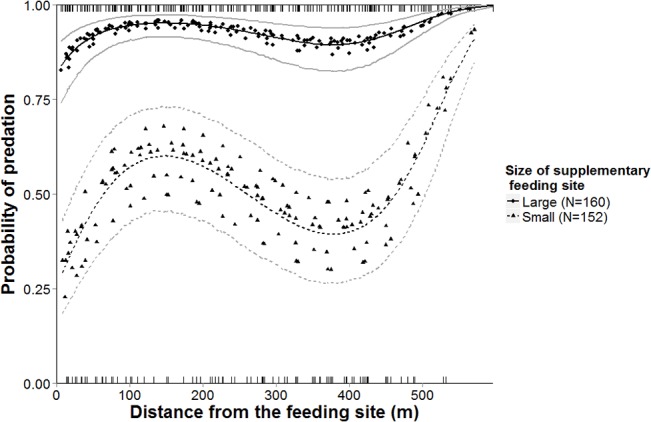
Predicted probability of nest depredation in relation to the amount of food and distance from the feeding sites.Predictions (EBLUPs, denoted as dots or triangles) and estimation (denoted as lines) of predation risk for artificial ground nests, according to the best GLMM in the first experiment. Nest fate is measured on a binomial scale (0 – nest survived, 1 – nest depredated); notches at the top and bottom of the figure indicate the distance of nests from wild boar feeding sites in the experiment and their fate. The solid black line indicates estimated predation risk for nests in the vicinity of large feeding sites (>50 kg of feed present); the dashed black line represents estimated predation risk for nests in the vicinity of small feeding sites (<25 kg of feed present), grey lines denote ± 1 SE.